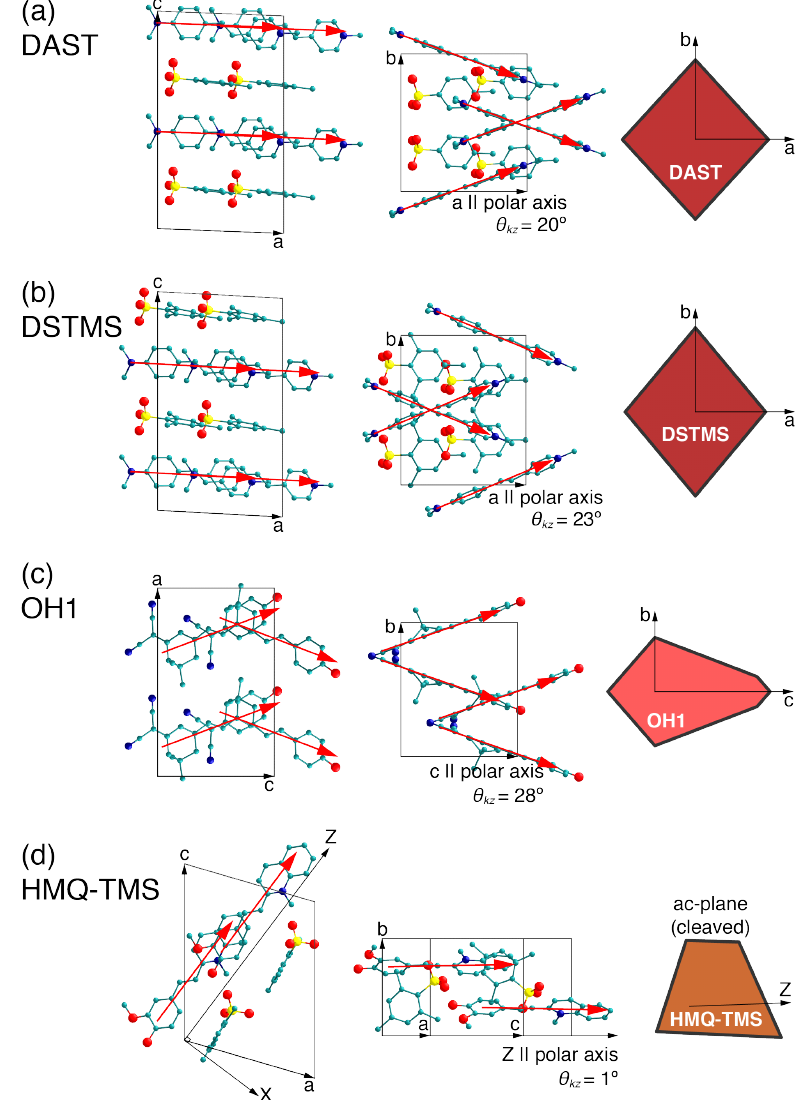
Figure 4. Crystal structures and the dominant sample morphology of some of the most well investigated organic NLO crystals for THz-wave generation during the last decade: the stilbazolium salts DAST ( a ) [22,41–43] and DSTMS ( b ) [32,44], the non-ionic configurationally locked polyene crystal OH1 ( c ) [45,46] and the quinolinium salt HMQ-TMS ( d ) [47]. The structures are available at the Cambridge Crystallographic Centre (CCDC) for the corresponding publications. The red arrows indicate the direction of the main charge-transfer axis of the NLO chromophores. The typical plate-like sample morphologies used in THz applications (as-grown for DAST, DSTMS, OH1 and cleaved for HMQ-TMS) have been drawn based on the information given in the corresponding